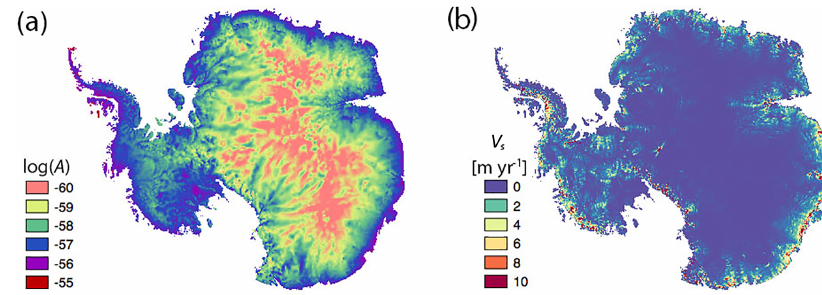
Figure A2. Creep parameter ( A : s − 1 Pa − 3 ) shown in log scale (a) . Estimated surface velocity due to ice creep ( V s )